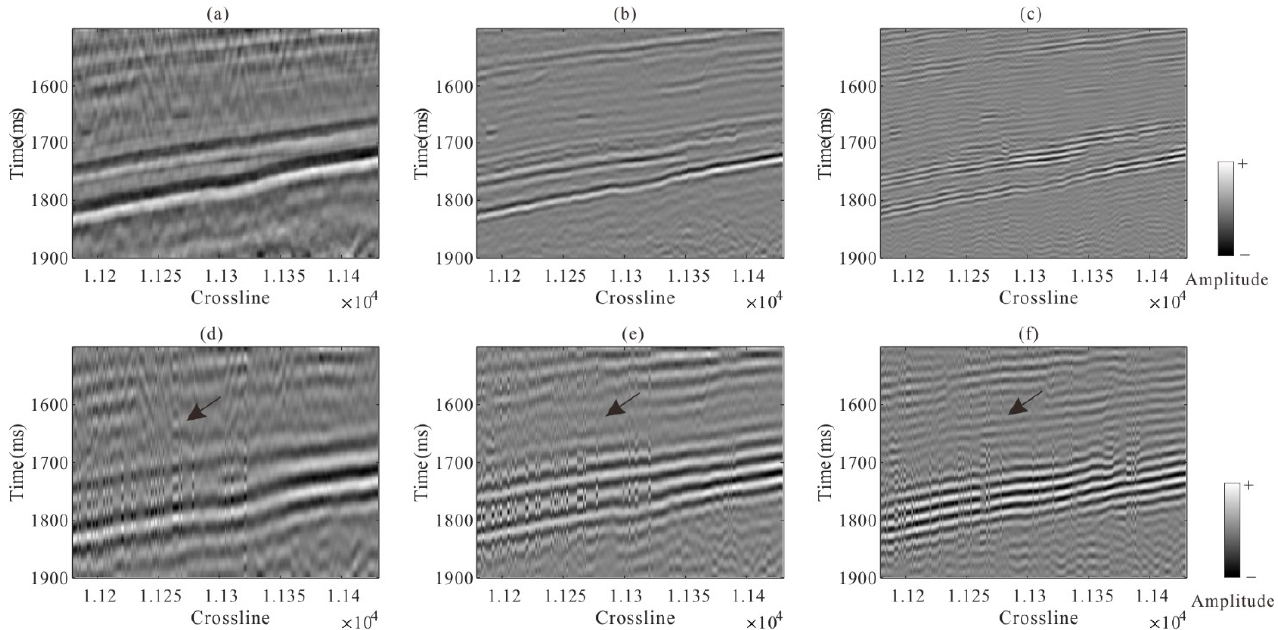
Figure 7. The decomposed components of the seismic vertical profile AA’ by using the MTVMD and the VMD methods. ( a – c ) are the components from the MTVMD method; ( d – f ) are the components from the VMD method. Black arrows indicate the lateral inconsistency in seismic profile.